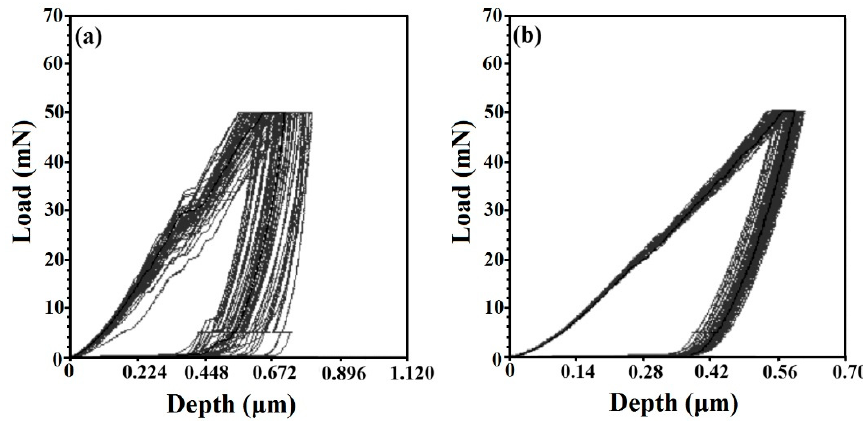
Figure 5. Penetration curves of the indenter of ( a ) TiN / TiO 2 coating deposited on treated Co–Cr substrate and ( b ) TiN / TiO 2 coating deposited on untreated Co–Cr substrate.